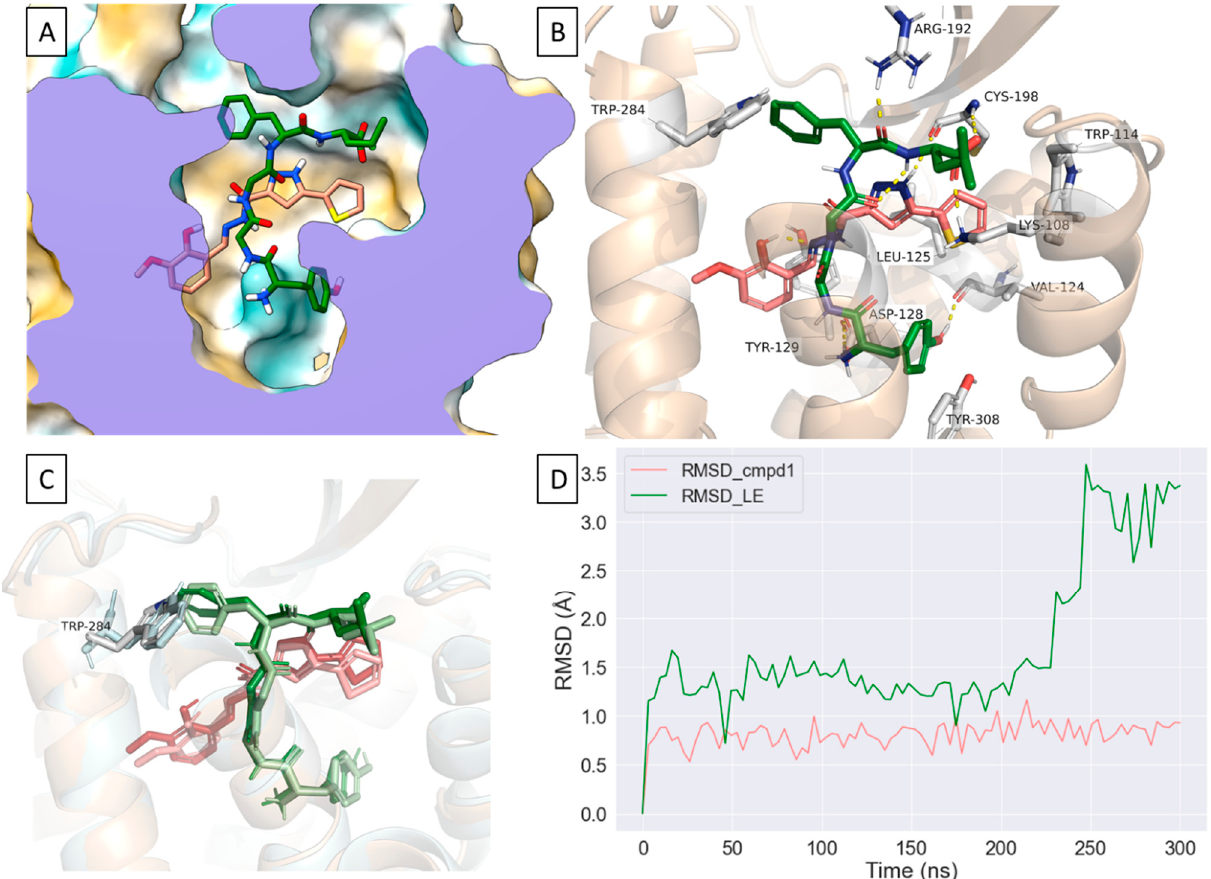
Figure 6. Molecular dynamic simulation of Compound 1 bound to the δ OR in the presence of Leu-enkephalin. ( A ) . a representative binding pose for compound 1 in the presence of Leu-enkephalin obtained from a 300 ns MD simulation where compound 1 stably occupies the partially hydrophobic pocket. ( B ) . Leu-enkephalin forms H-bonds and water mediated interactions with K108 2.63 , D128 3.32 , R192 ECL2 , C198 ECL2 , H301 7.35 , C303 7.37 and hydrophobic interactions with Y308 7.42 whereas compound 1 mostly interacts with W114 ECL1 , L125 3.29 , C198 ECL2 and L200 ECL2 and K214 5.40 . ( C ) . Poses of Leu-enkephalin and compound 1 showing the first frame of a 300 ns MD simulation (Leu-enkephalin: light green, compound 1 : light pink, W284: cyan) aligned on the clustered poses of Leu-enkephalin and compound 1 (Leu-enkephalin: dark green, compound 1 : red, W284 6.58 : light grey). ( D ) . A rolling average of 3 ns of the RMSD of compound 1 in the presence of Leu-enkephalin obtained from a 300 ns MD simulation showing a relatively stable pose for compound 1 whereas the disruption of Leu-enkephalin’s interaction with W284 6.58 causes a relatively large change in its RMSD.